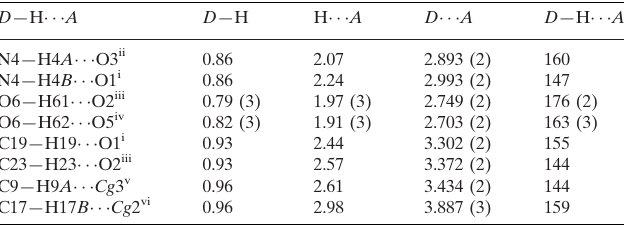
Hydrogen-bond geometry (A˚ , (cid:3)